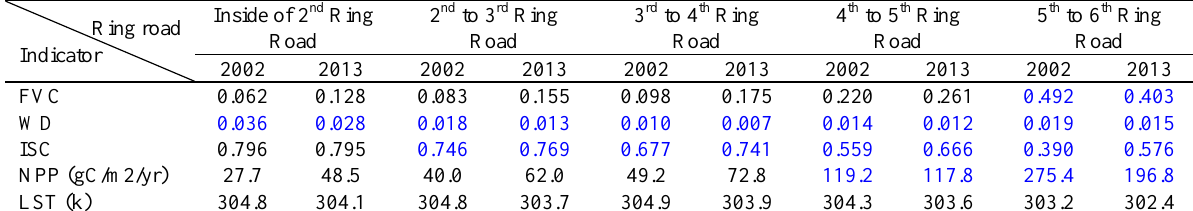
Table 2. Ecological environmental change inside of Beijing 6 th Ring